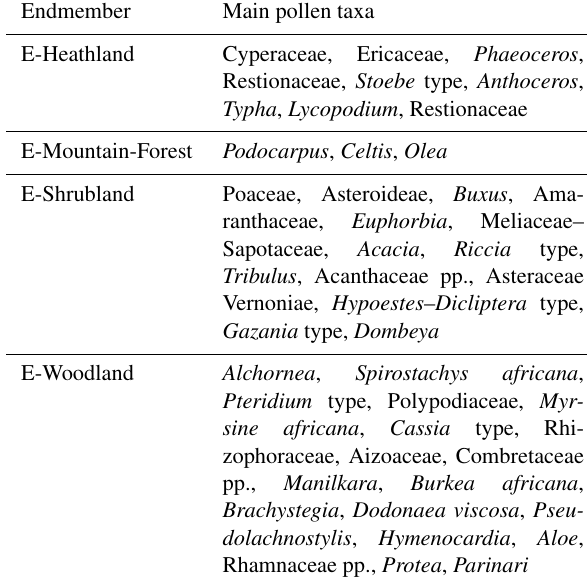
Table 2. Interpretation of the